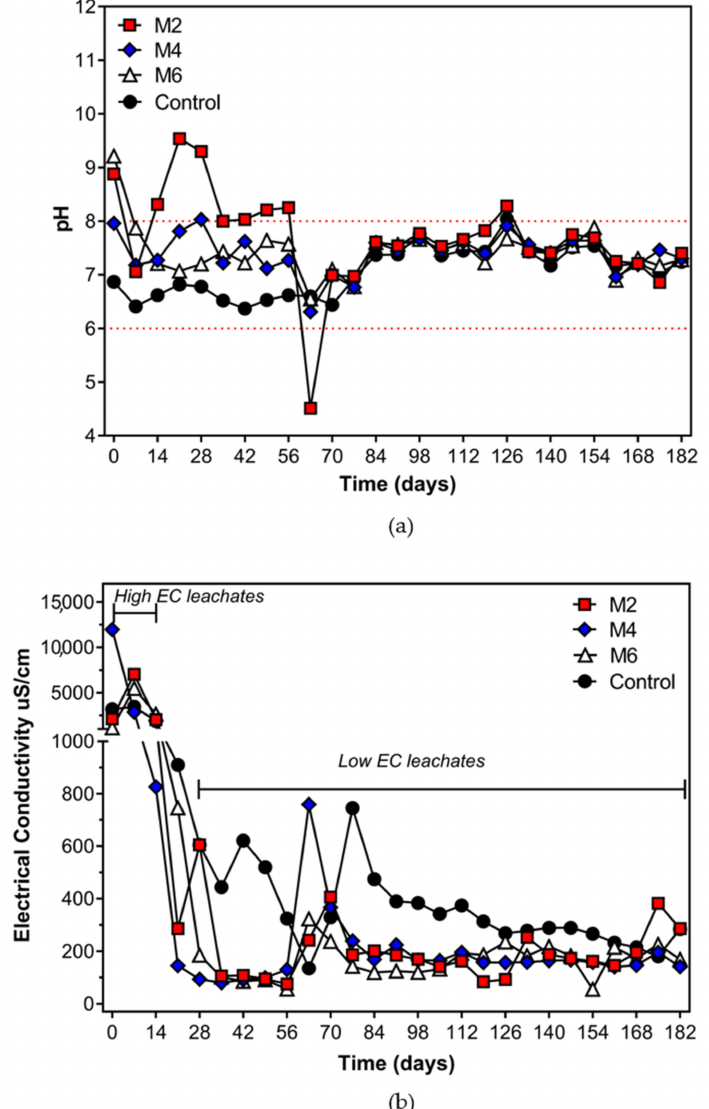
Figure 3. pH ( a ) and electrical conductivity ( b ) evolution over time in the humidity cells tests for paste-tailing